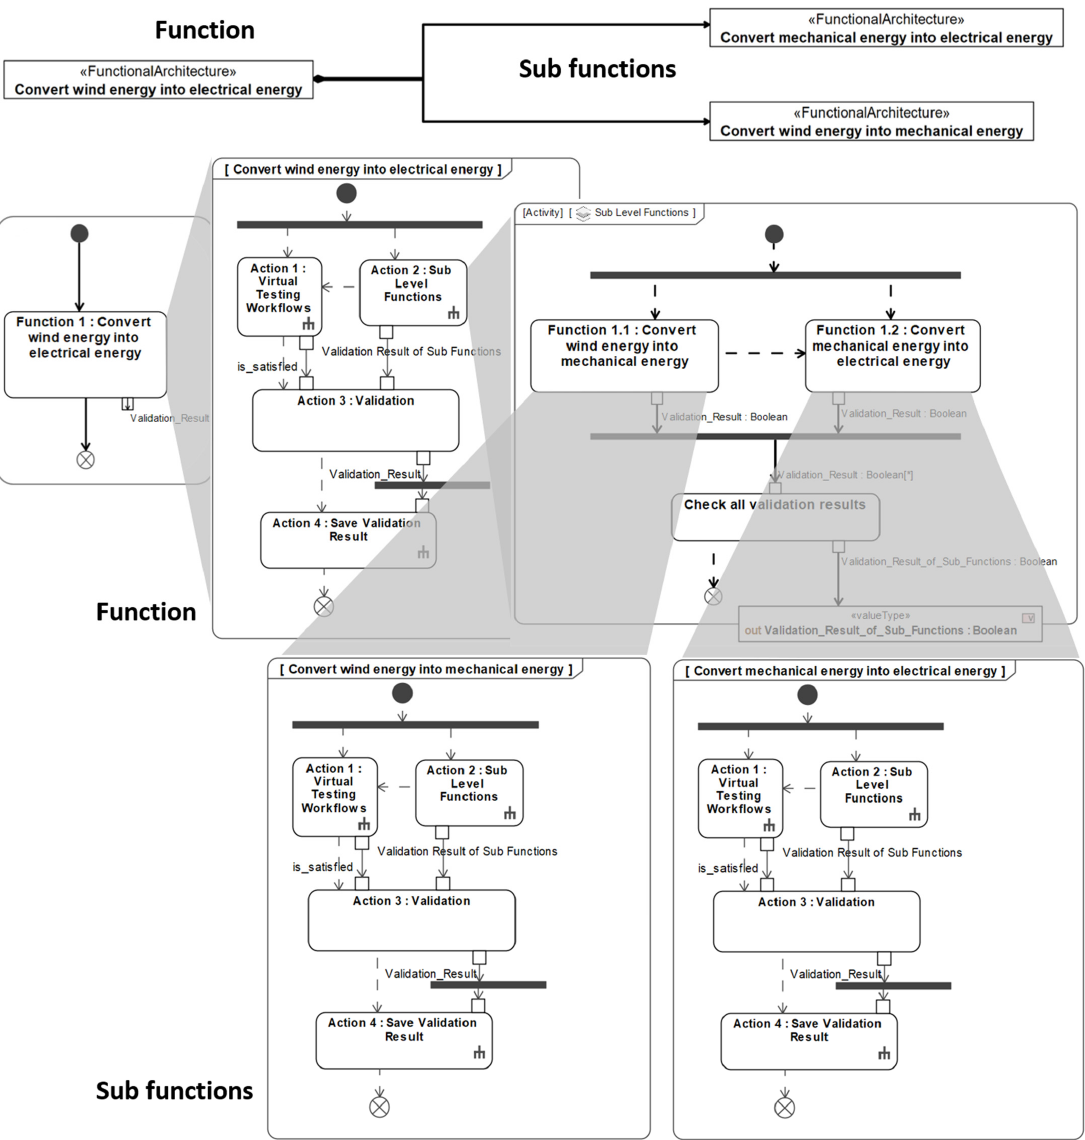
Figure 5. The framework of the hierarchical functional validation workflows in SysML.